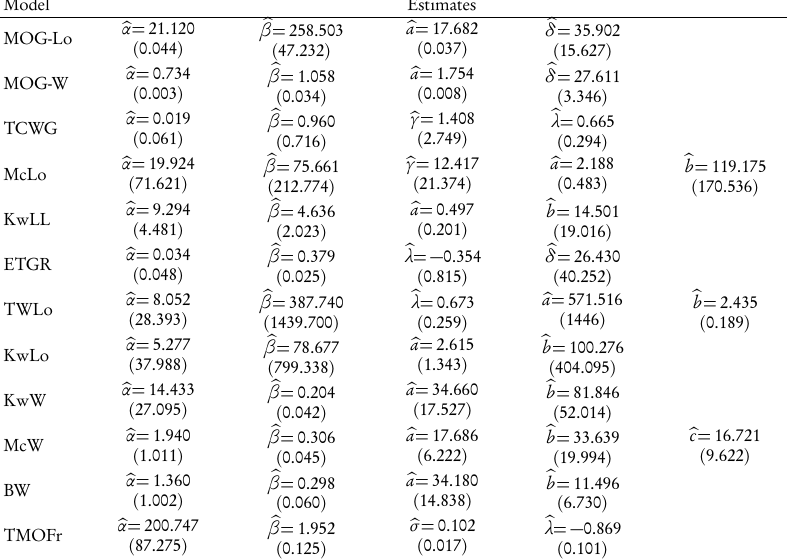
MLEs and standard errors (in parentheses) for failure times of windshield data. Model